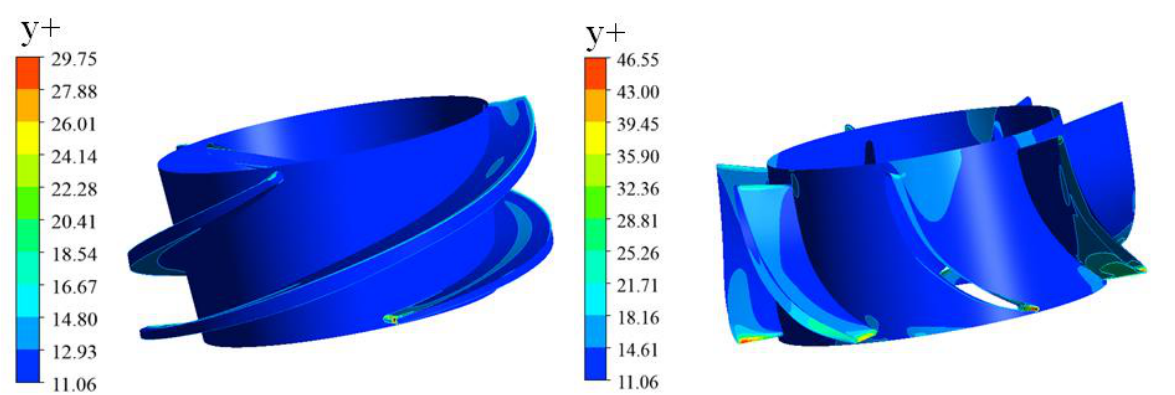
Figure 3. y+ of the impeller and diffuser.